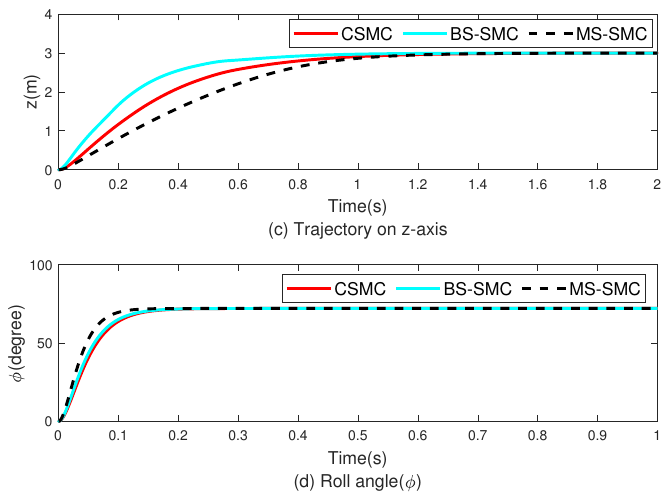
Figure 5. Tracking of quadrotor for x , y , z , and φ .